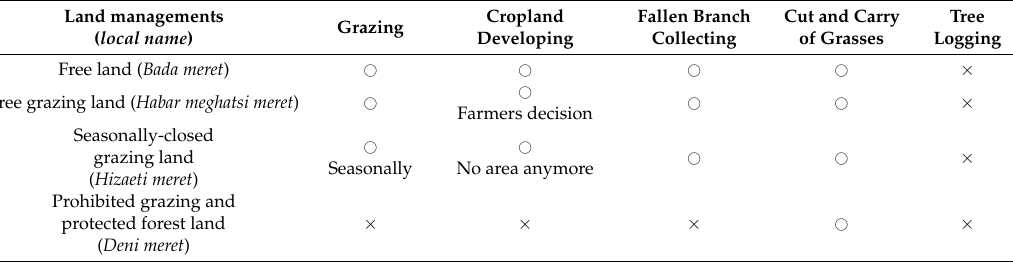
Table 1. Land managements in the Adi Zaboy watershed study